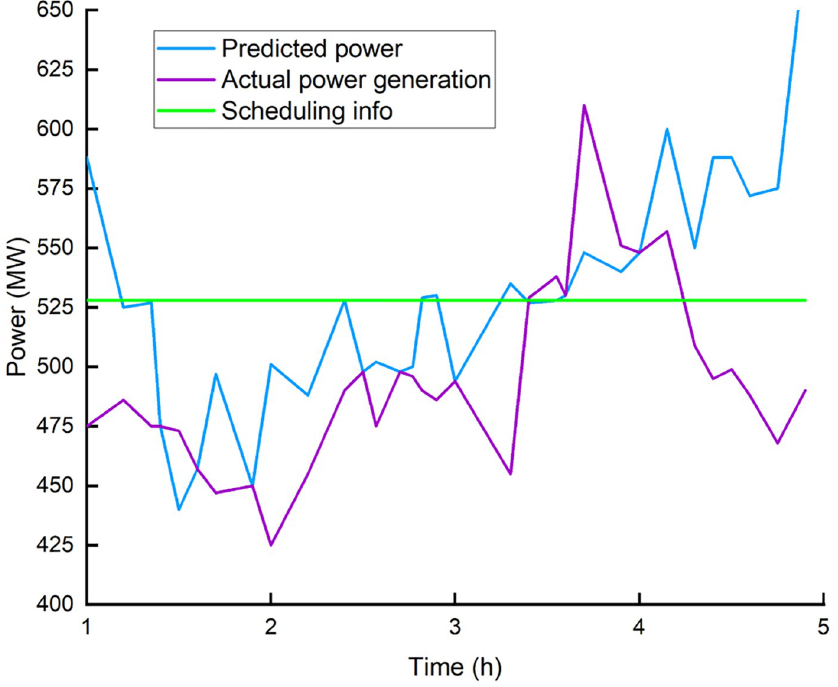
Fig 3. Data of wind power and generating schedule. (a) 1 st wind farm, (b) 2 nd wind farm, (c) 4 th wind farm.